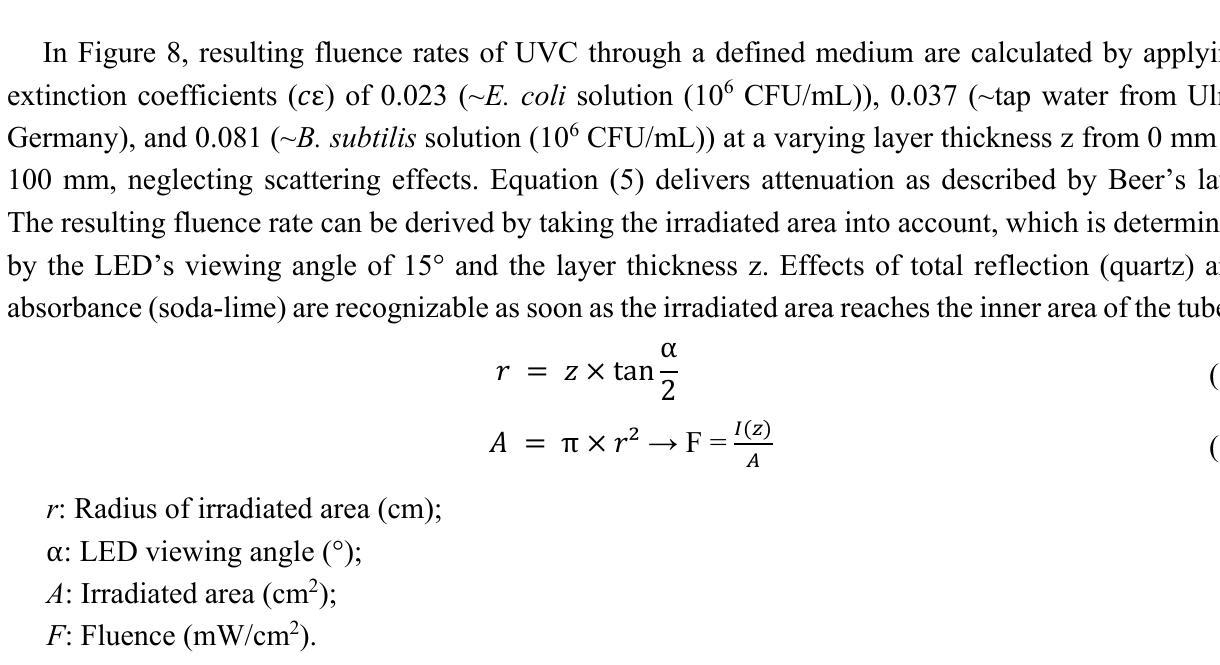
Figure 7. Absorption of tap water (region: Ulm, Germany), 0.9% NaCl solution, E. coli DSM 498, and B. subtilis DSM 402 solution (1–3 × 10 6 CFU/mL; 0.9% NaCl, distilled water); reference: pure water; layer thickness: 10